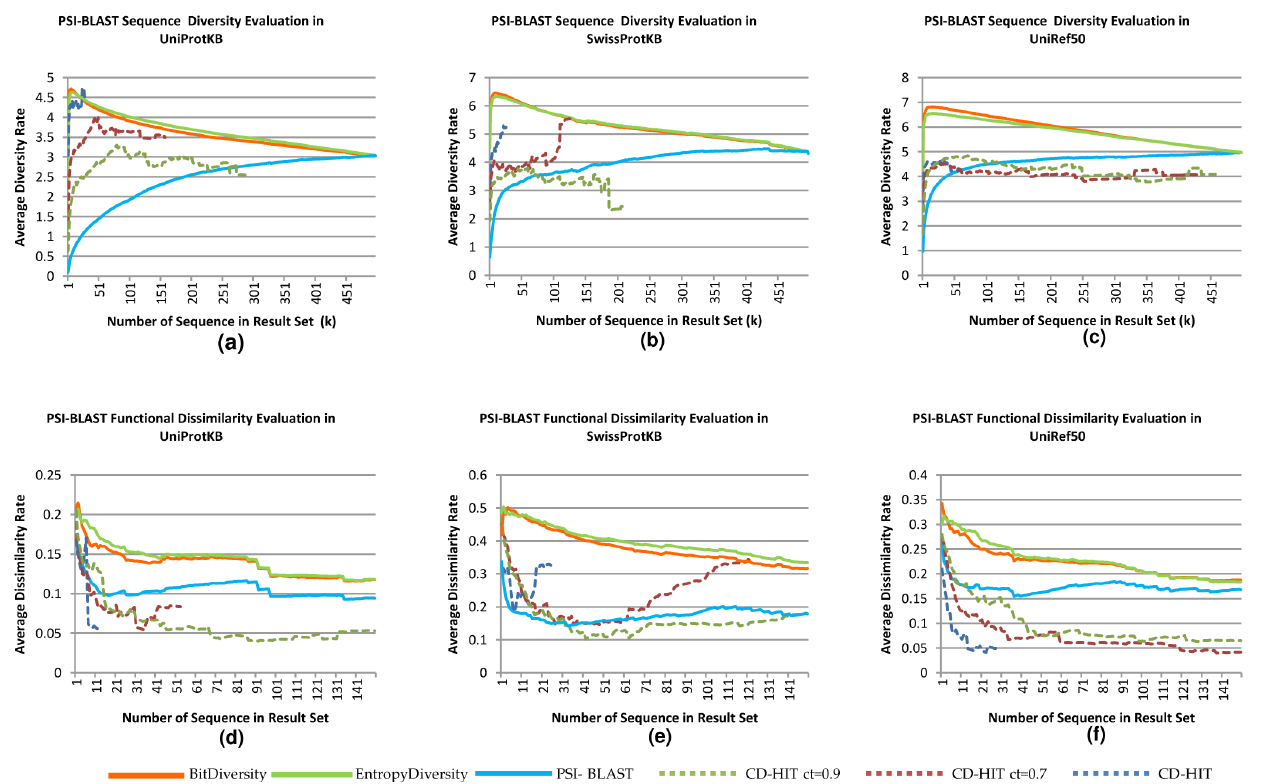
Fig. 5. Comparisons based on sequence diversity and functional dissimilarity measures in different databases: UniProtKB, SwissProtKB and UniRef50. The experiments are done by using OXBench dataset on PSI-BLAST Web services. For a, b, and c, the x axes represent the average sequence diversity rate calculated with Rao’s entropy method and the y axes show the size of the diversified set(k). For d, e, and f, the x axes represent the average functional dissimilarity rate based on Wang et al.’s similarity on molecular function GO DAG. The y axis is the same as the a, b, and